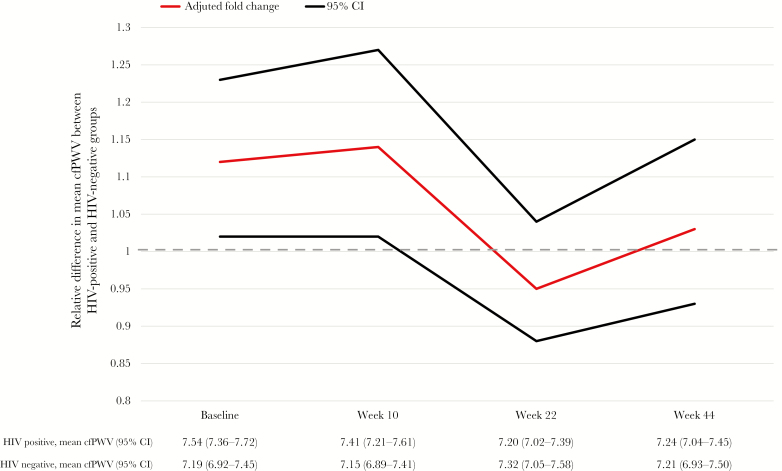
Effect of human immunodeficiency virus (HIV) infection on the carotid femoral pulse wave velocity (cfPWV) over 44 weeks after adjustment for age, sex, diastolic blood pressure, and hemoglobin level. The same model is calculated for each individual time point. CI, confidence interval.